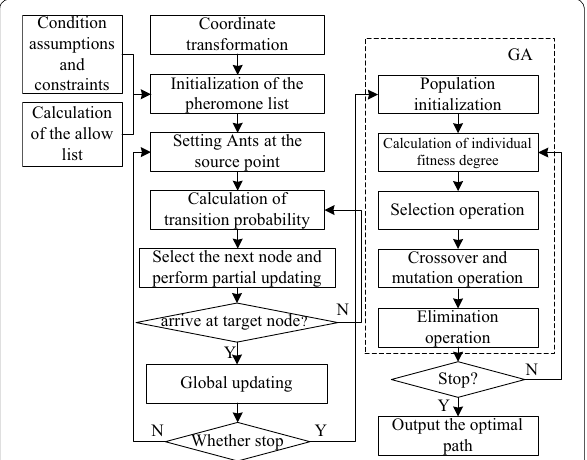
Figure 5 AC‑GA‑based 3D path optimization operation